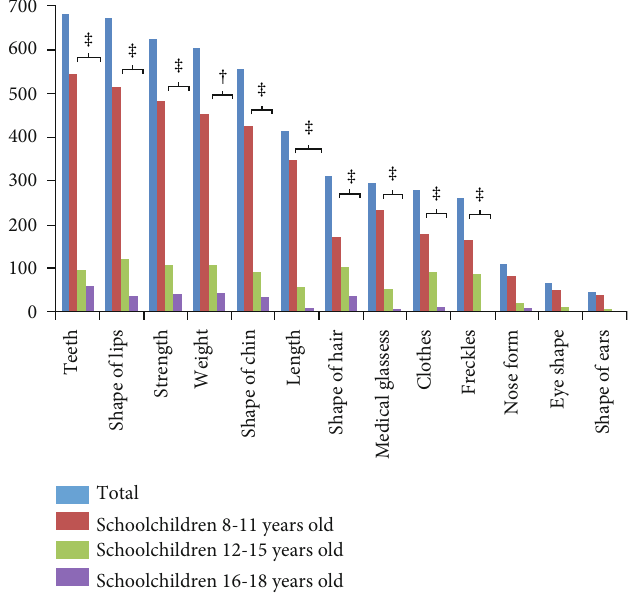
Figure 2: Frequency distribution of physical features reported as targets for victimization according to age group. ∗ p < 0 : 05 , † p < 0 : 01 , and ‡ p < 0 : 001